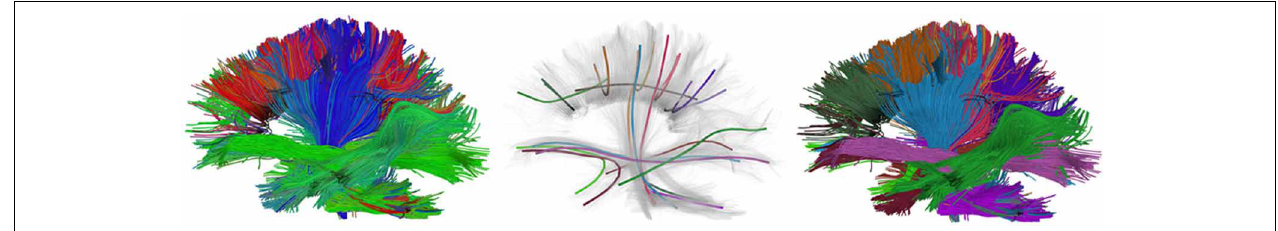
FIGURE 7 | Left: An example of EuDX streamline tracking applied on a real human brain dataset and color-coded with a standard orientation colormap. Middle: Showing the QuickBundles centroids with random colors. Right: Showing the clusters color-coded with their corresponding centroid